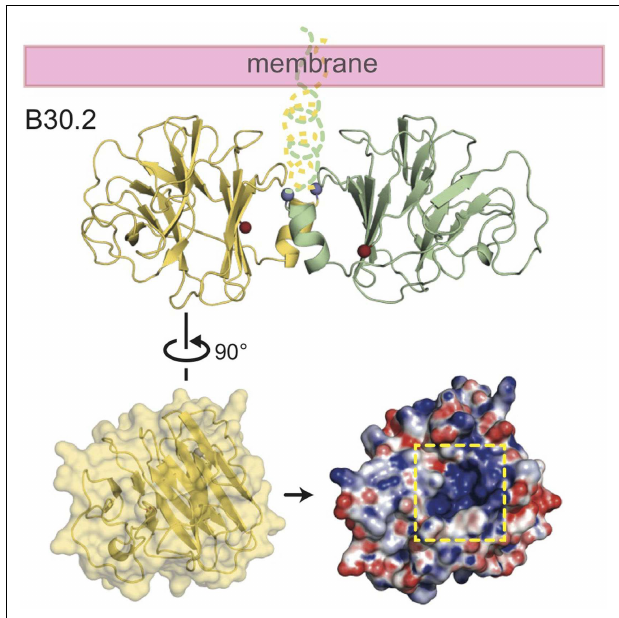
FIGURE 6 | Structure of the intracellular B30.2 domain of BTN3A1 . Shown is a cartoon diagram of the B30.2 domain dimer identified in the crystal lattice. Monomer 1 is shown in yellow, monomer 2 in green. N- and C-termini are shown as blue and red spheres, respectively, as is the putative orientation of these molecules in relation to the cell membrane. Turning monomer 1 approximately 90° and generating an electrostatic representation of the B30.2 surface, a highly positively charged pocket is clear (indicated by the dashed yellow box).